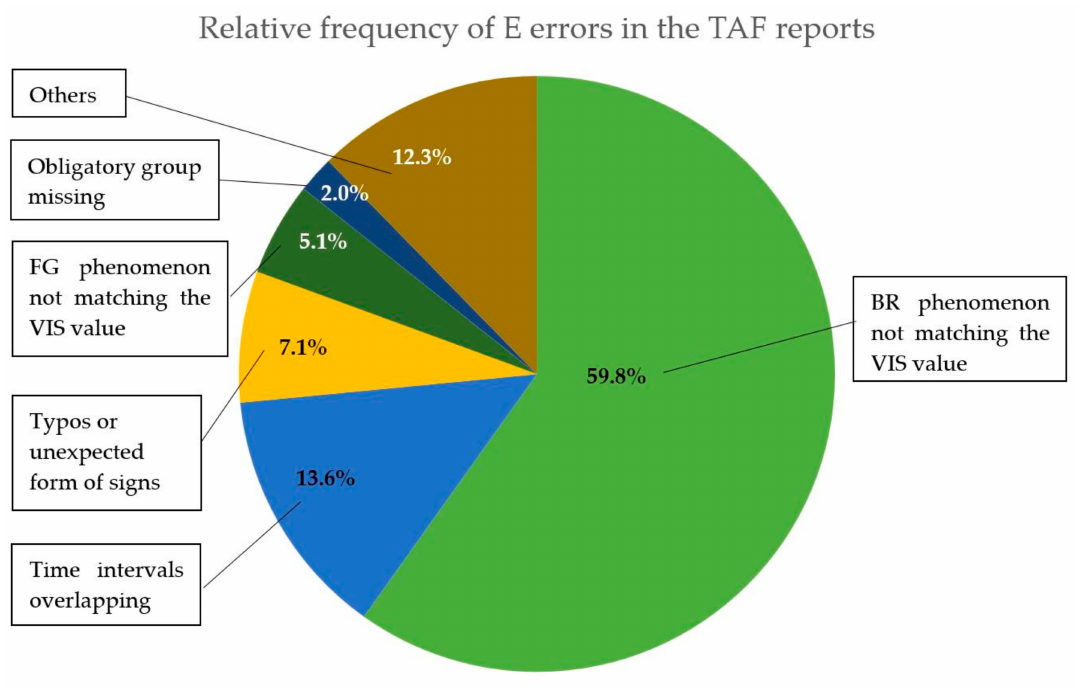
Figure 4. Relative frequency of E errors in the TAF